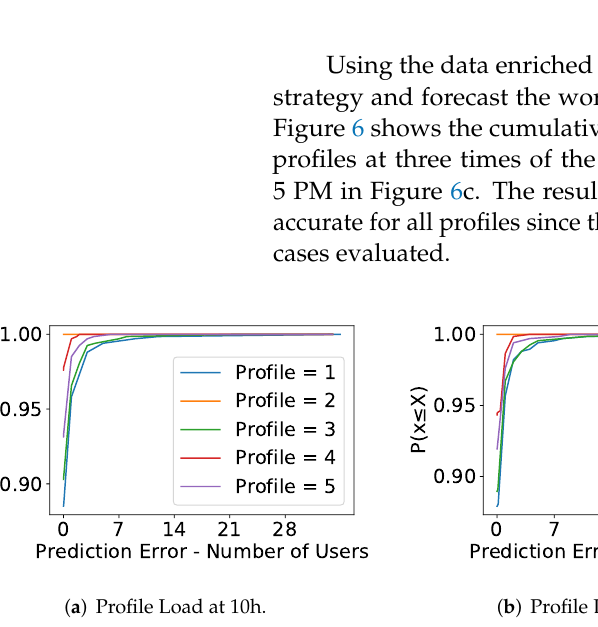
Figure 6. Comparison of the cumulative distribution functions (CDF) of the profile load forecast errors at the grid points at ( a ) 10 AM, ( b ) 1 PM and ( c ) 5